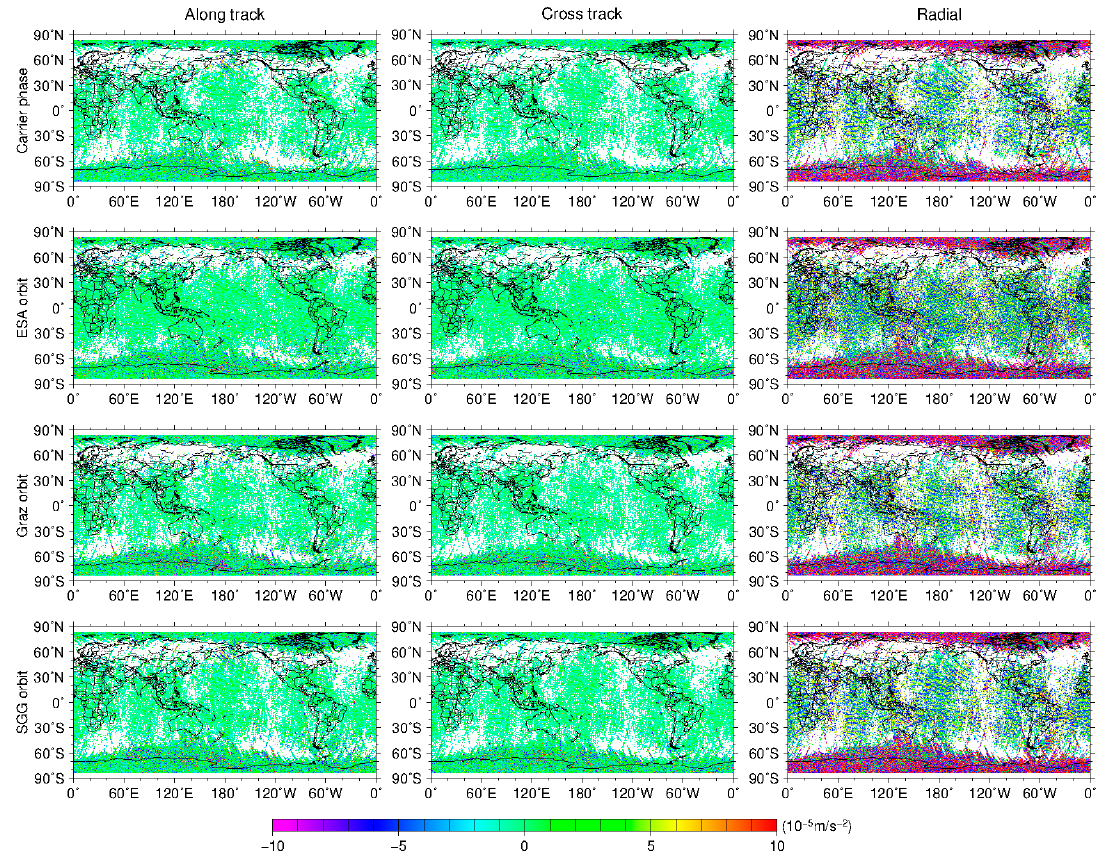
Figure 1. Spatial distribution of the gross errors with regard to the residual accelerations (unit: m / s 2 ).